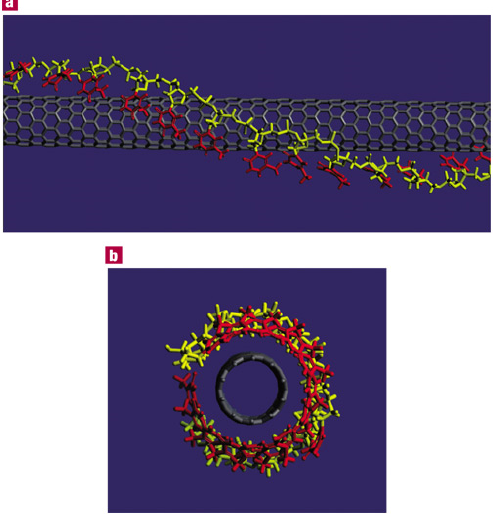
Figure 1. A theoretical model of structure of single-stranded DNA (ssDNA) and single-walled carbon nanotubes (SWNTs) hybrids, proposed by Zheng et al. (10,0) SWNT and poly(T) were assumed for the calculation (Reprinted from reference [1] with